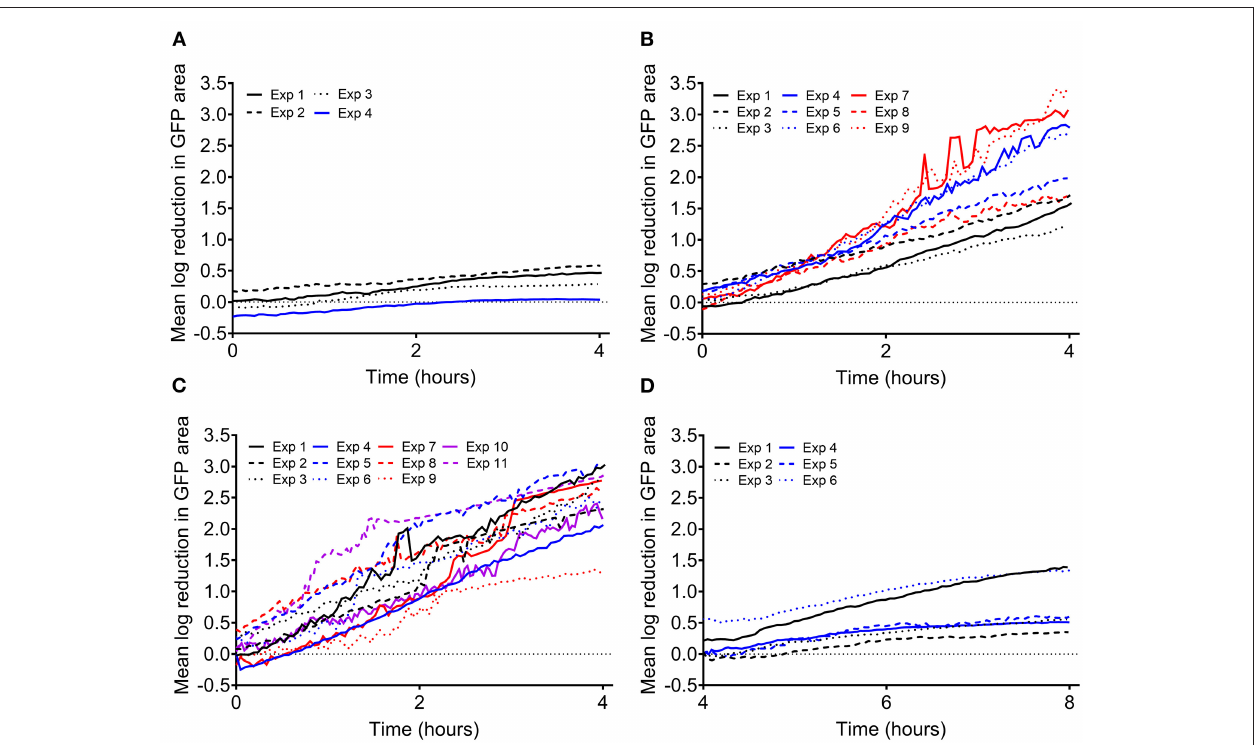
FIGURE 3 | Log reduction in surface attached S. aureus biomass during PMN challenge compared to the average of the two corresponding control FOVs (no PMNs). Each line represents the average of two FOVs from a given experiment unless otherwise noted. Data shown from (A) density experiments with a low number of PMNs (2.39 ± 1.13 × 10 3 PMNs/cm 2 , 8 FOVs, depicted in Figure 1A , well II) and (B) density experiments with a medium number of PMNs (1.53 ± 1.25 × 10 4 PMNs/cm 2 , 18 FOVs, depicted in Figure 1A , well III). (C) Data shown from density experiments with high PMNs (Exps 1–5, 2.57 ± 1.18 × 10 4 PMNs/cm 2 , 14 FOVs, depicted in Figure 1A , well IV) and control wells from head start experiments containing single cells and PMNs (Exps 6–11, 1.09 ± 0.31 × 10 4 PMNs/cm 2 , 12 FOVs, depicted in Figure 1B , well III). Except for experiment 5, which contains 6 FOVs of the same condition, each line represents the average of two FOVs from a given experiment. (D) Data shown from head start experiments where aggregated bacteria were challenged with PMNs (1.72 ± 0.93 × 10 4 PMNs/cm 2 , 12 FOVs, depicted in Figure 1B , well